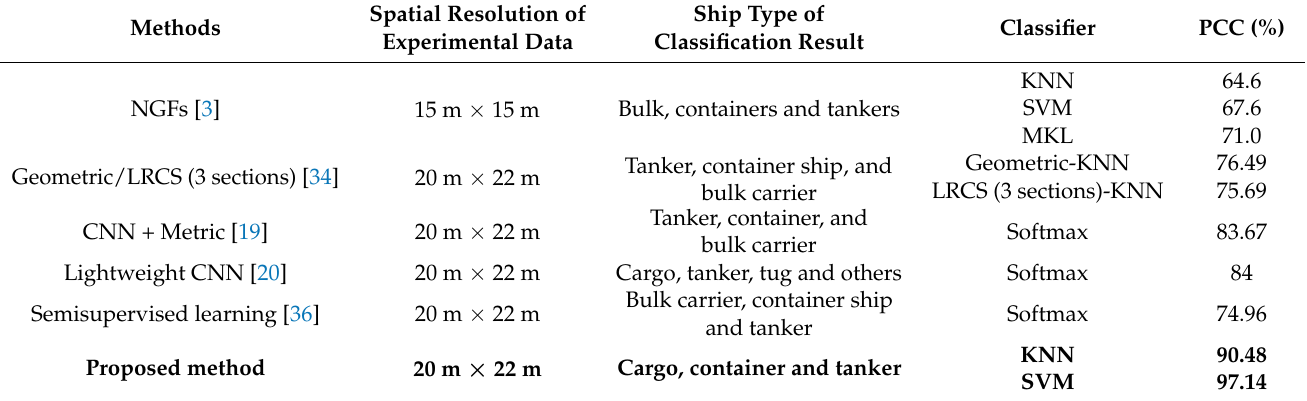
Table 2. The PCC of the proposed method and the method for comparison in moderate-resolution SAR images.